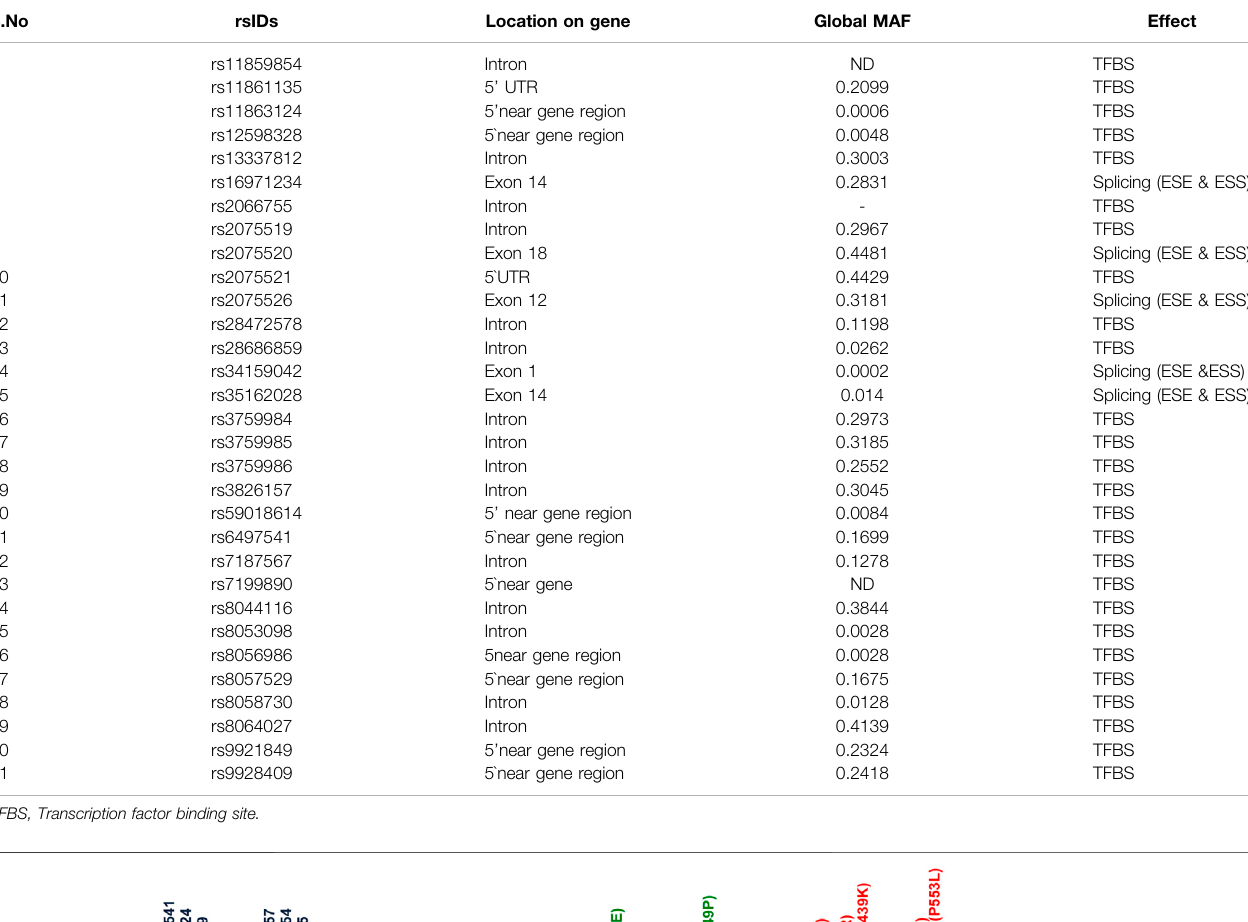
TABLE 6 | FuncPred results showing 31 SNPs predicted to affect the hZP2 gene regulation. S.No